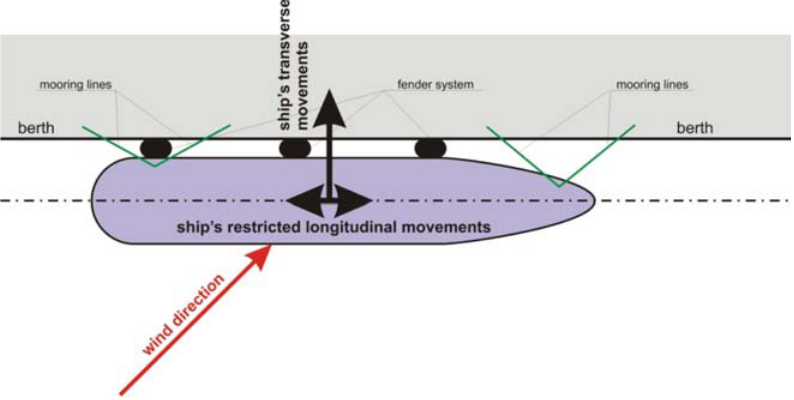
Fig. 9. Aerodynamic loads directed to the berth